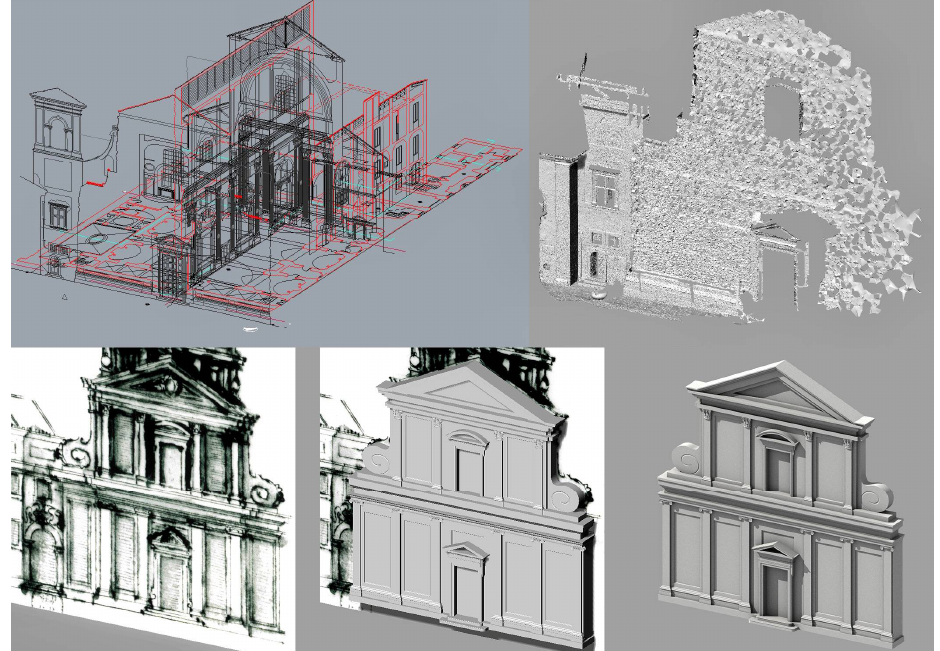
Figure 4. Workflow containing the different steps that led to the reconstruction of the facade model. Initially, the direct survey drawings were placed in the space; Based on survey, both the point cloud and the historical drawings of the facade have been aligned; Then, a three-dimensional hypothesis was